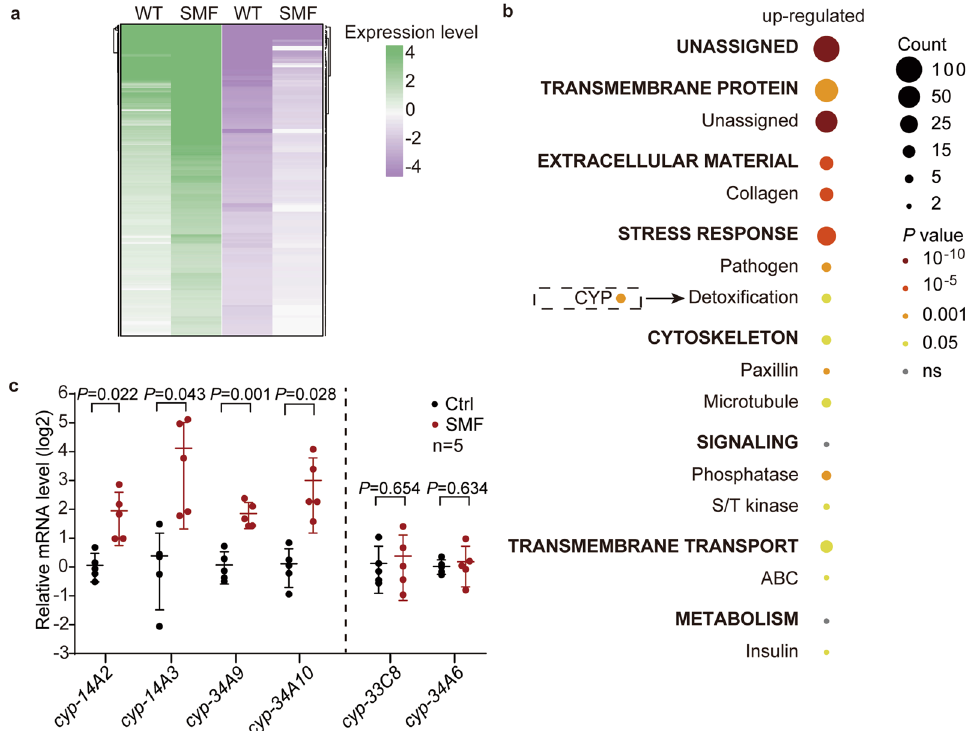
Figure 3. A group of cytochrome P450 genes are induced by the static magnetic field. ( a ) A heatmap depicting the differentially expressed genes (DEGs) in worms at day 0 of adulthood upon 10 mT SMF treatment. ( b ) Gene enrichment analysis of the upregulated DEGs upon SMF treatment by WormCat. Categories 1 and 2 are differentiated by capitalization and bold fonts. Category 2 are shown below the corresponding Category 1. Categories 1 with RGS bigger than 10 were shown. See Supplementary Table 3 for more details. ( c ) RT-qPCR analysis of the indicated CYP genes in day 1 adult worms with or without SMF treatment. Unpaired t